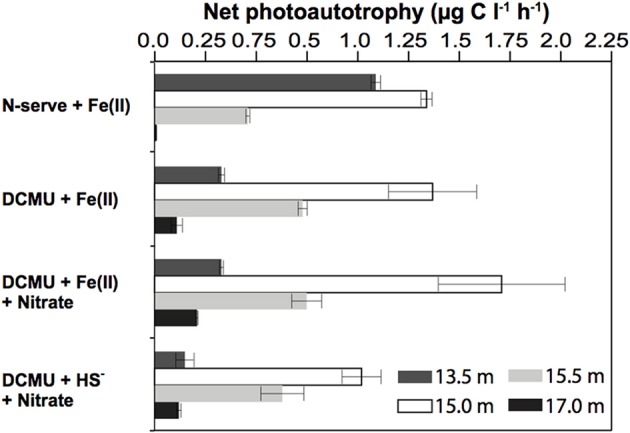
In situ light dependent inorganic carbon uptake in presence of potential substrates for iron- and sulfur-transforming microorganisms. Results show highest stimulation of bicarbonate uptake upon Fe(II) addition at 15 m and 15.5 m, the depths where anoxygenic phototrophs were most abundant. Net photosynthetic carbon uptake was obtained by subtracting the dark incubation values from the carbon uptake in the light. N-serve and DCMU were added to inhibit nitrification and PS(II) of oxygenic phototrophs, respectively. Means of duplicate experiments are given, with bar ends indicating highest and lowest values. Winter stratification conditions (11/Feb/2008).